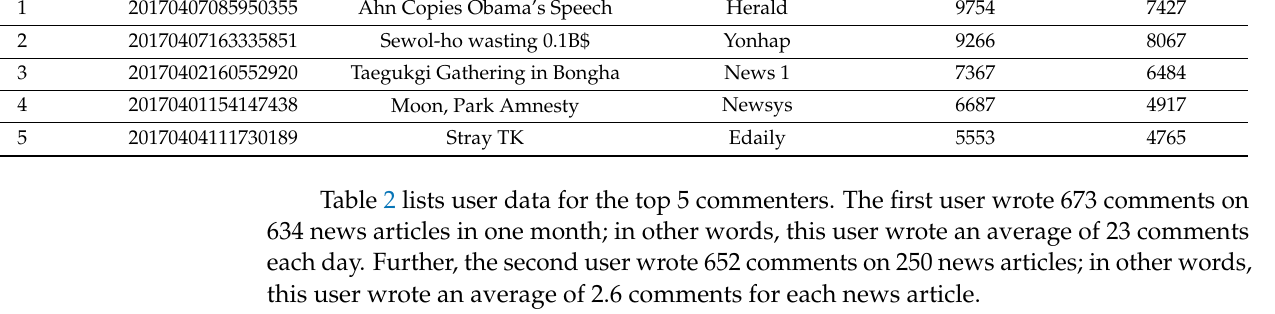
Table 1. Top 5 news articles in terms of number of comments.